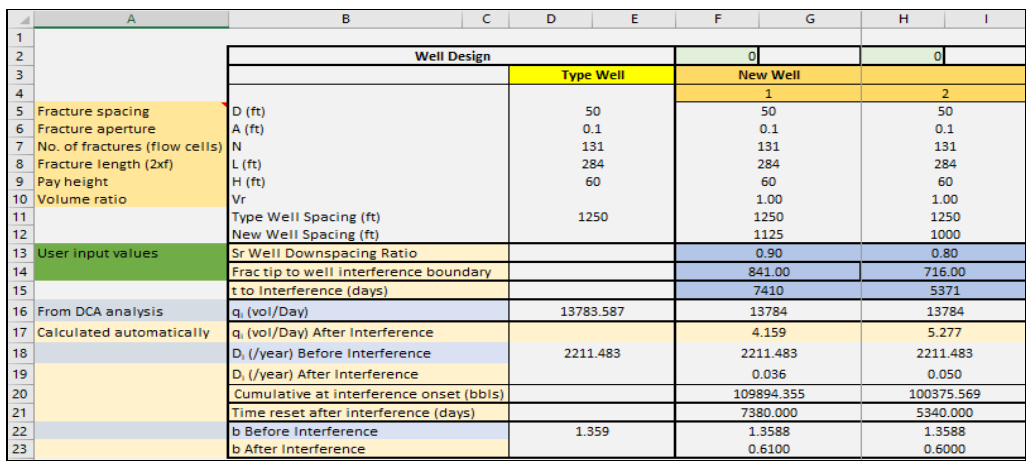
Figure A2. Screen capture of “Type well DCA fitting” tab to obtain forecast parameter to match type well production data .